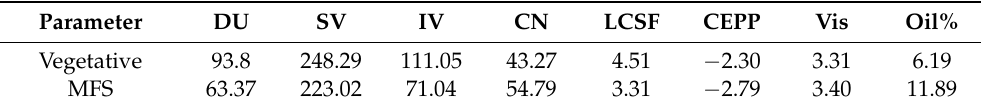
Table 3. Some fuel properties of N. oculata grown under vegetative and multifactor stress conditions (BSAE, as well as NaCl and nitrogen